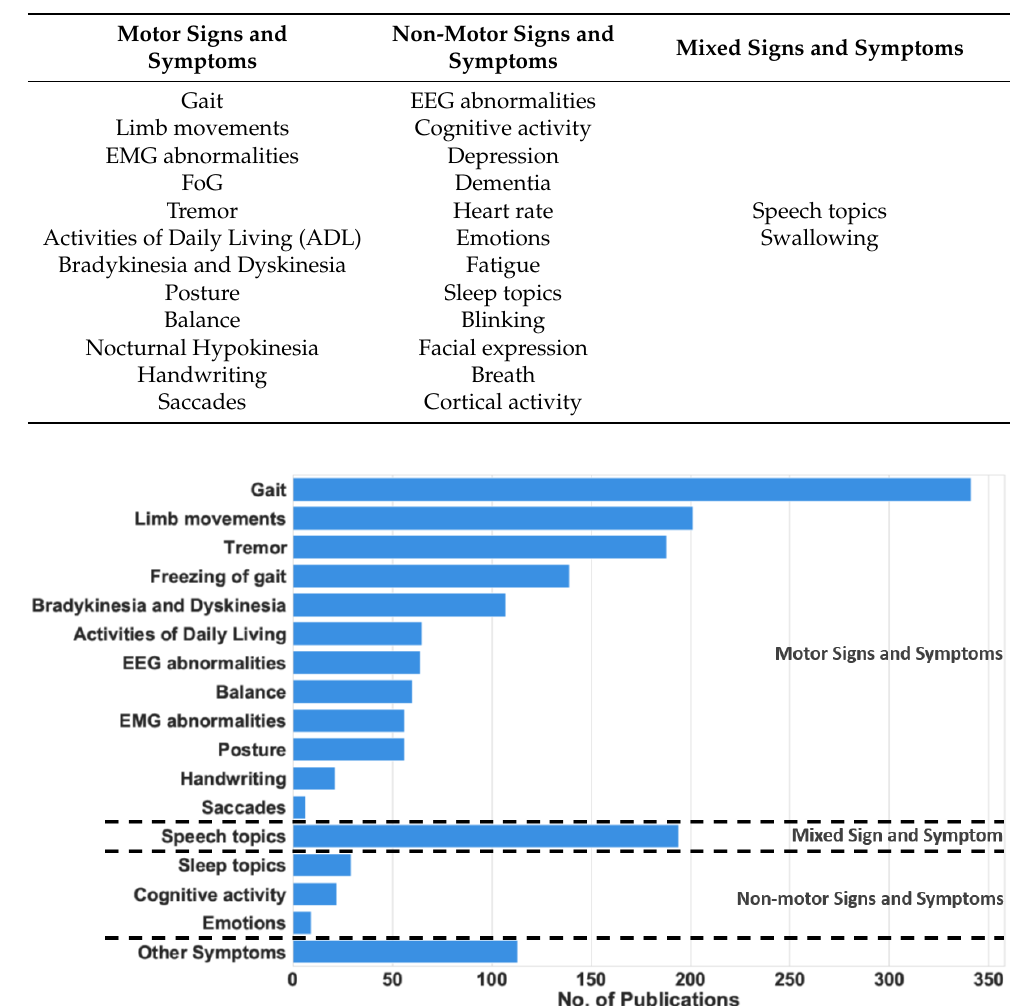
Figure 1. The number of research publications between 2008 and 2021 that measure each sign and